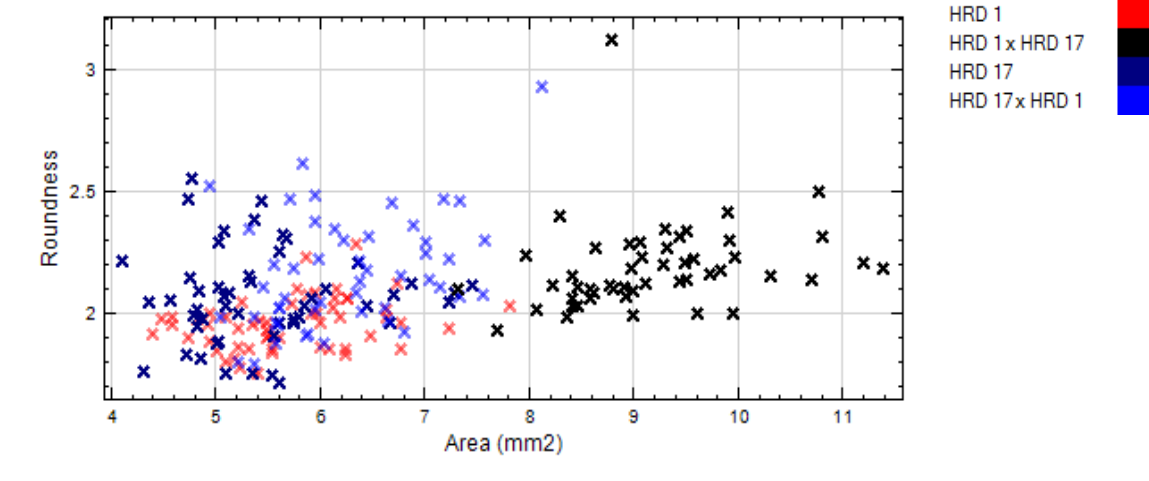
Figure 3. nCDA discrimination on seed shape feature (area vs.